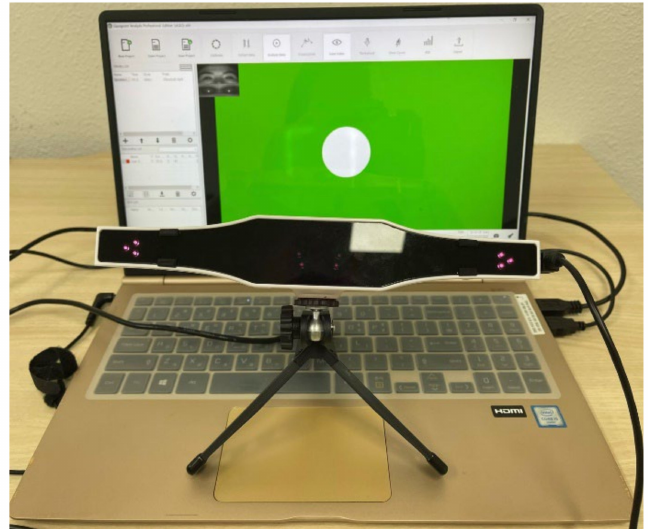
Figure 3. Gazepoint GP3 HD Eye